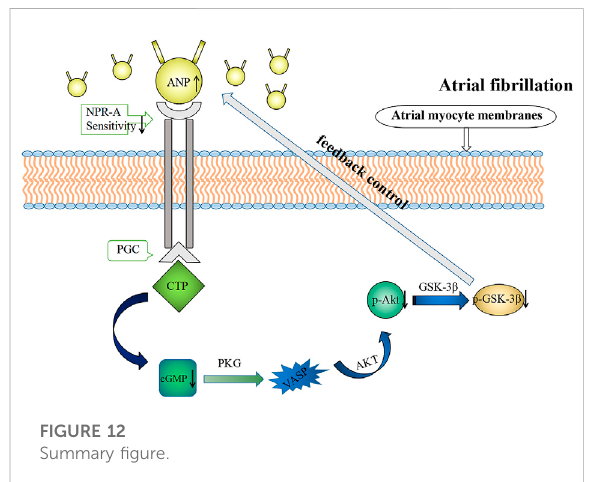
FIGURE 12 Summary fi